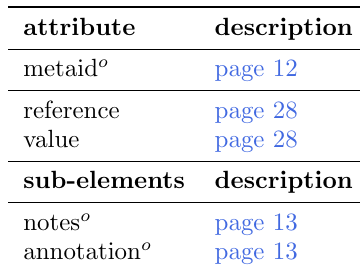
Table 2.8: Attributes and nested elements for slice. o denotes optional elements and